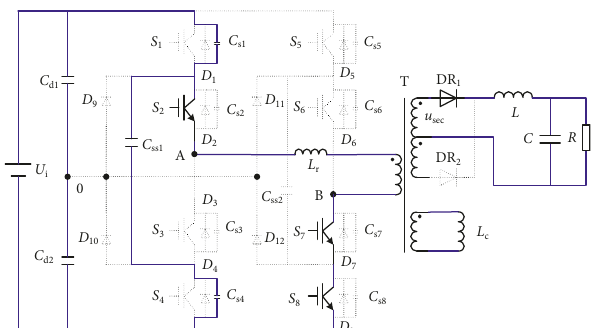
Figure 9: Equivalent circuit of mode 1.